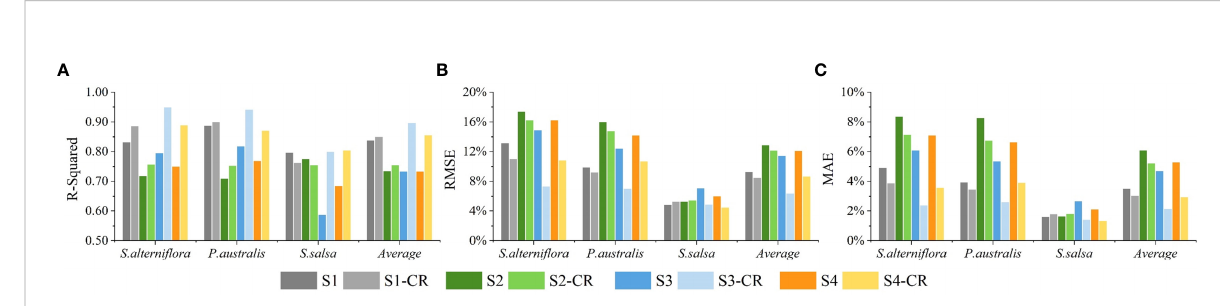
FIGURE 5 (A) R-square, (B) RMSE and (C) MAE of the fractional cover estimation of different salt marsh vegetation species from four scenarios using K- Nearest Neighbor Regression model. S1~S4: Scenario 1 ~ Scenario 4 based on the original Landsat imagery; S1-CR ~ S4-CR: Scenario 1 ~ Scenario 4 based on the cloud-removed Landsat imagery.